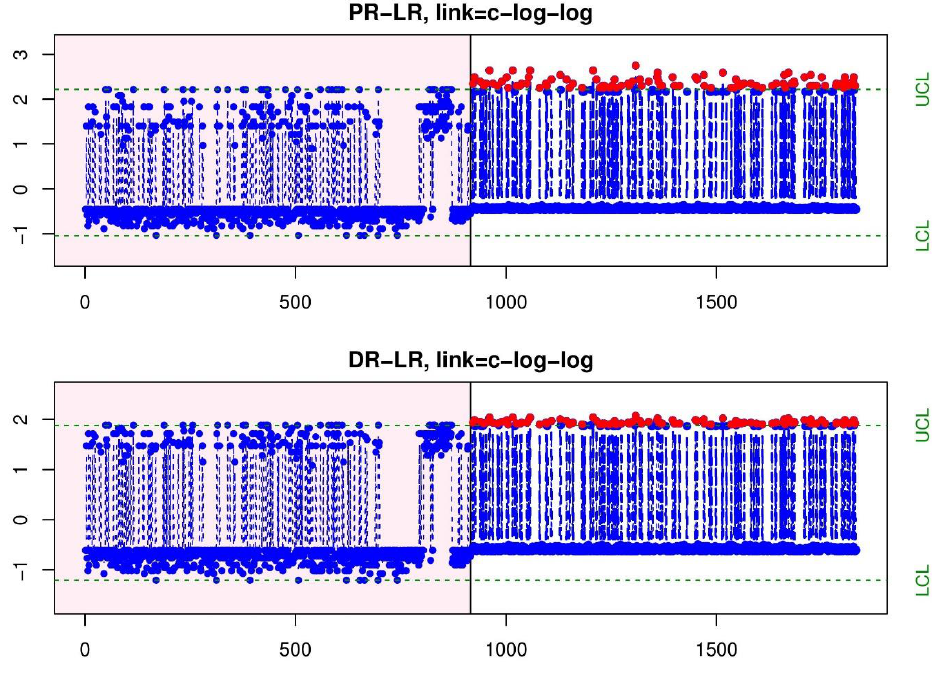
Figure 3. Control chart based on PR and DR with the probit link function.